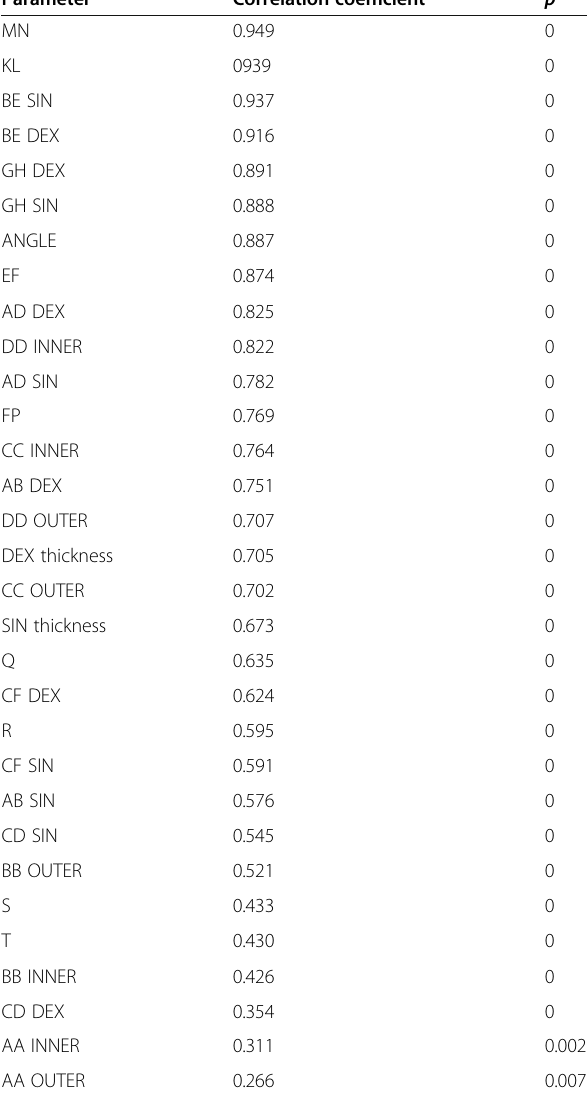
Table 6 Correlation between the metric parameter and sex, N = 100 Parameter Correlation